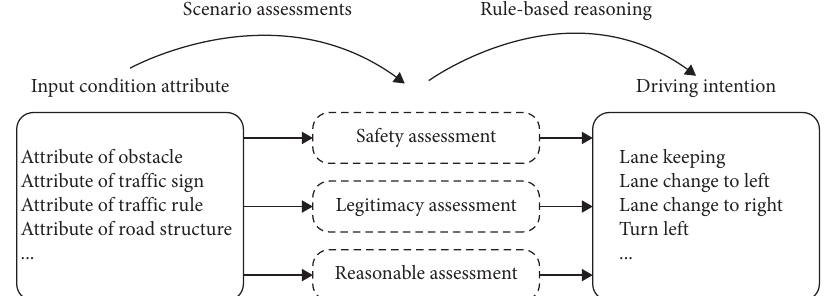
Figure 2: Driving intention prediction process.